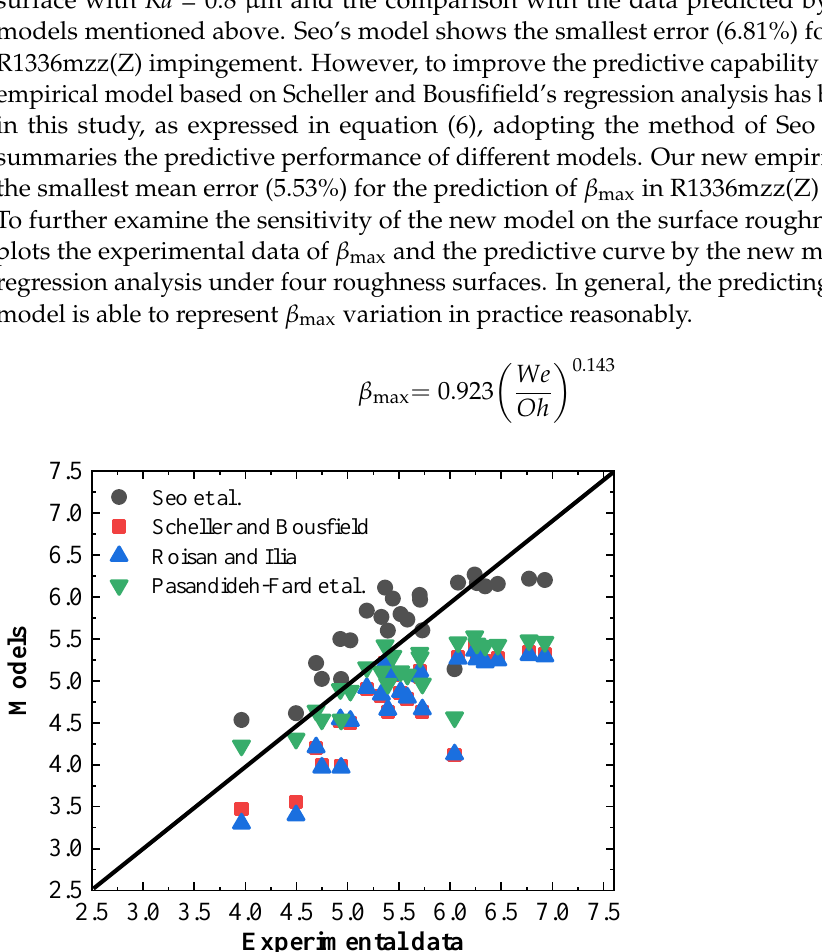
Table 2. Summary of models and their predictive mean errors.